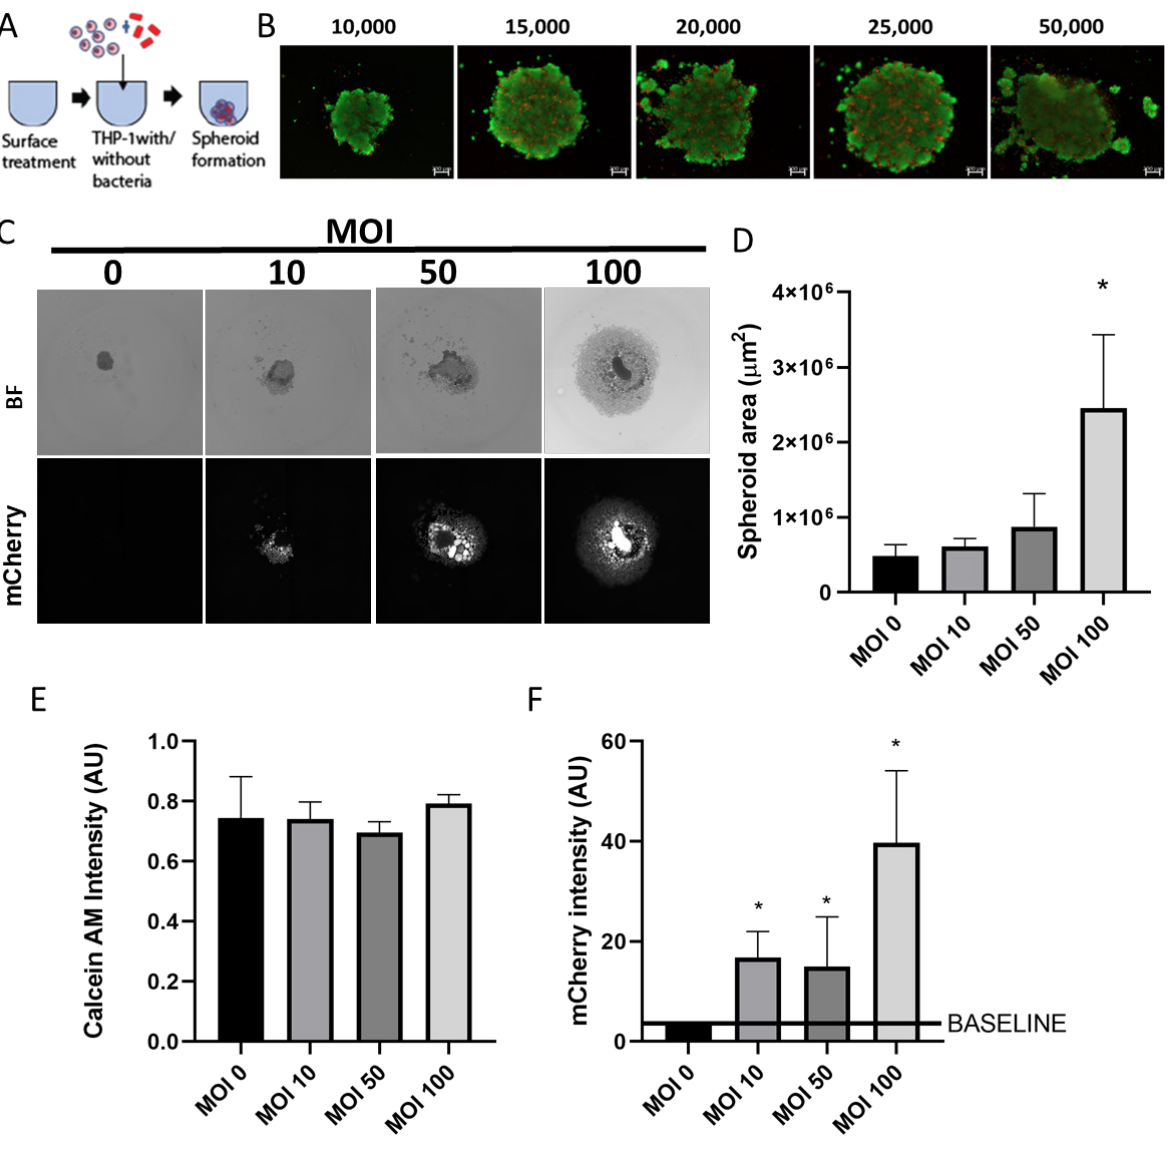
Figure 1: Formation of 3D spheroids and modeling mycobacterial infection. (a) Schematic of spheroid formation in 96 well U-bottom plate (b) Live dead staining of THP-1 cells seeded by varying cell number/well from 10,000-50,000 cells/well (c) Bright field and mCherry channel images of BCG mCherry infected spheroids infected with a varying multiplicity of infection (0-100). Quantification of spheroid area (d), Calcein AM intensity (e) and mCherry intensity (f) of spheroids infected with BCG mCherry at varying MOIs. * denotes statistical significance when compared to MOI 0 group at p<0.05 using one-way Anova and Tukey post hoc test. (n=5